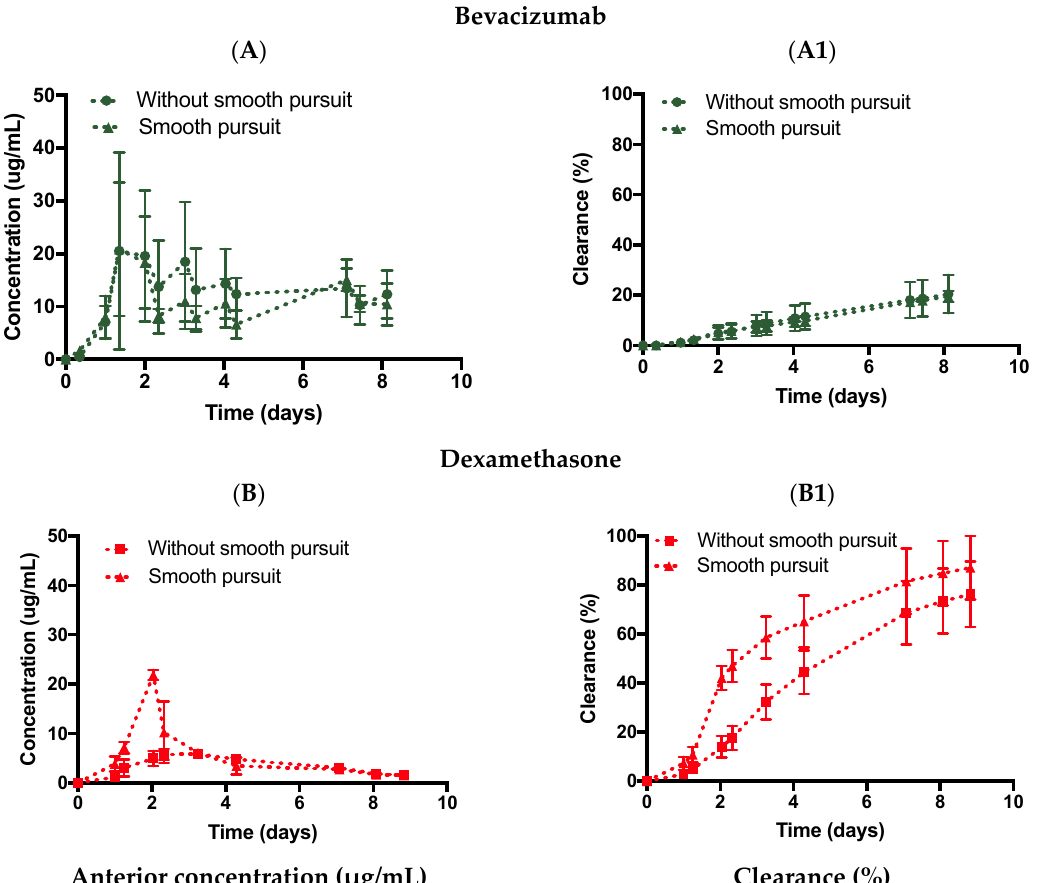
Figure 7. Effect of motion on the ciliary inflow model with ( A , A1 ) bevacizumab (1.25 mg, 50 µL) and ( B , B1 ) dexamethasone (0.1 mg, 100 µL) injected in SVF with and without slow pursuit. All data are presented as the mean (n = 5) and standard deviation (±STD).